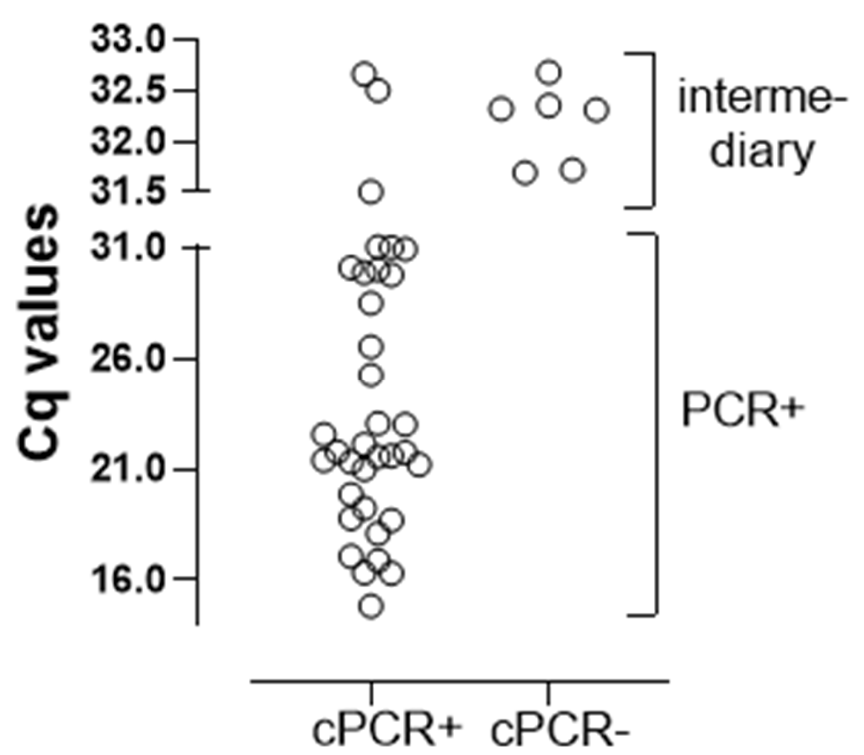
Figure 2. Comparison of the Cq values of the positive qPCR (n = 41) with the results of the cPCR performed in IS of patients with AIDS and suspected PcP. Each symbol represents one patient.